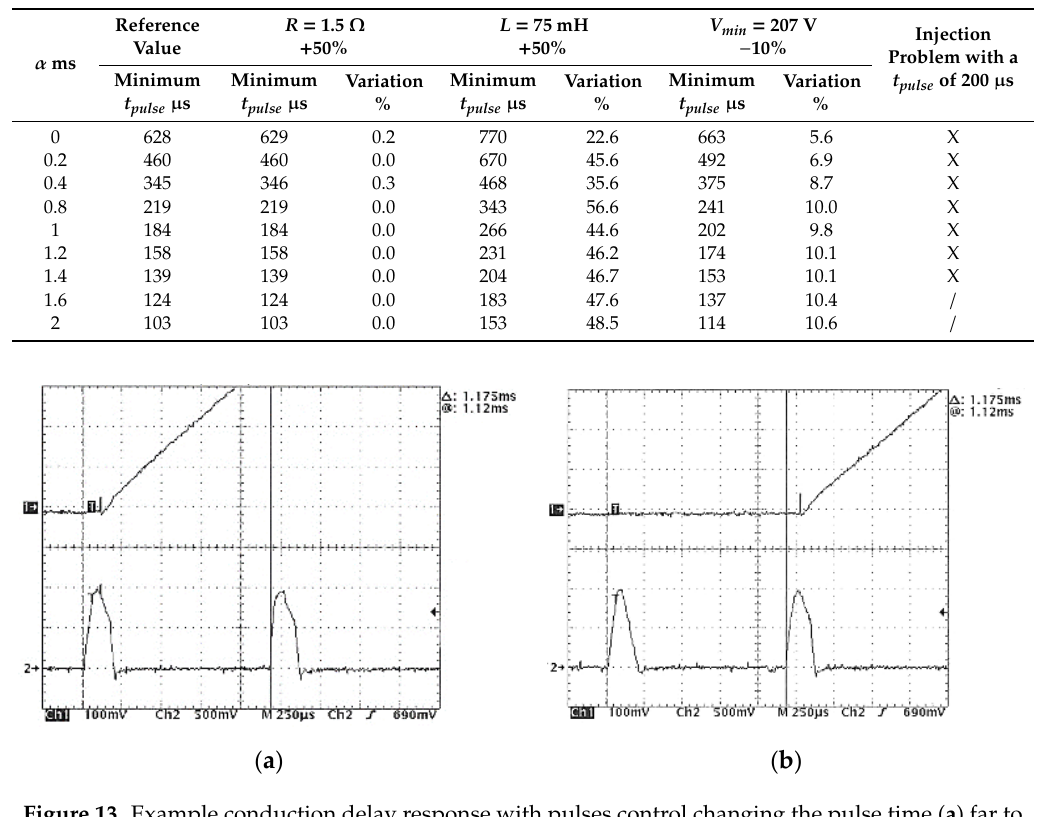
Figure 13. Example conduction delay response with pulses control changing the pulse time ( a ) far to the natural voltage zero crossing, ( b ) close to the natural voltage zero crossing (both pulses happen with positive voltage and the distance between two pulses is 1.12 ms).